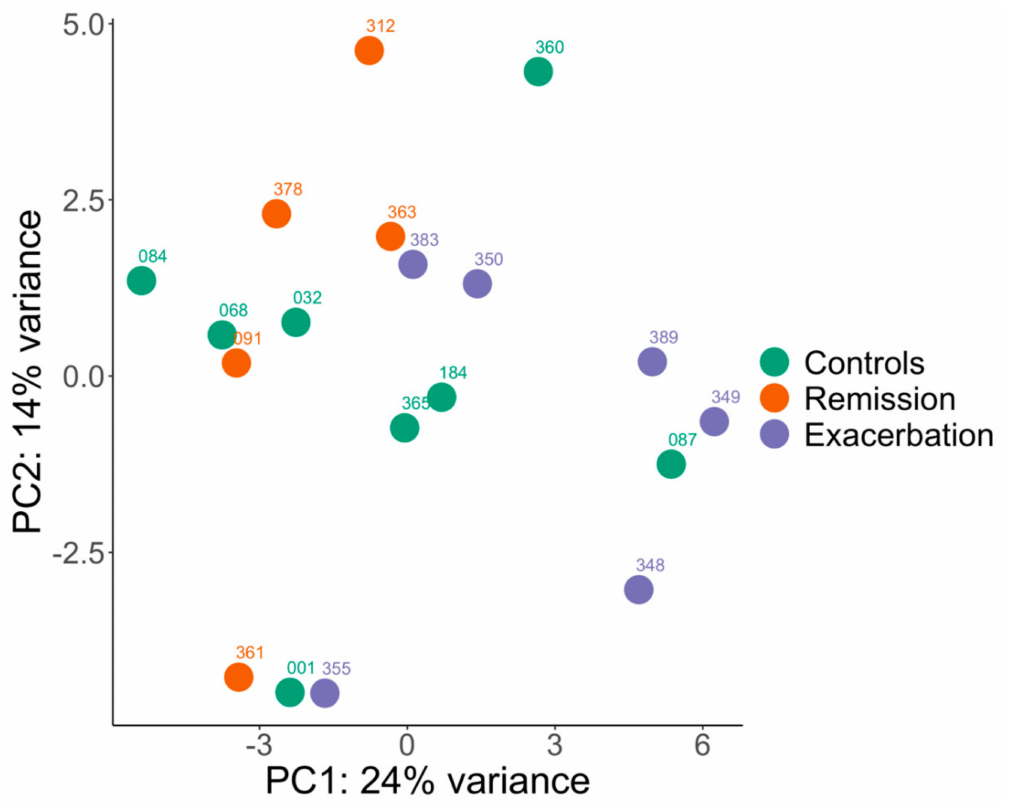
Figure A1. Principal component analysis (PCA) plot using the miRNA raw data. The labels of the data points indicate sample